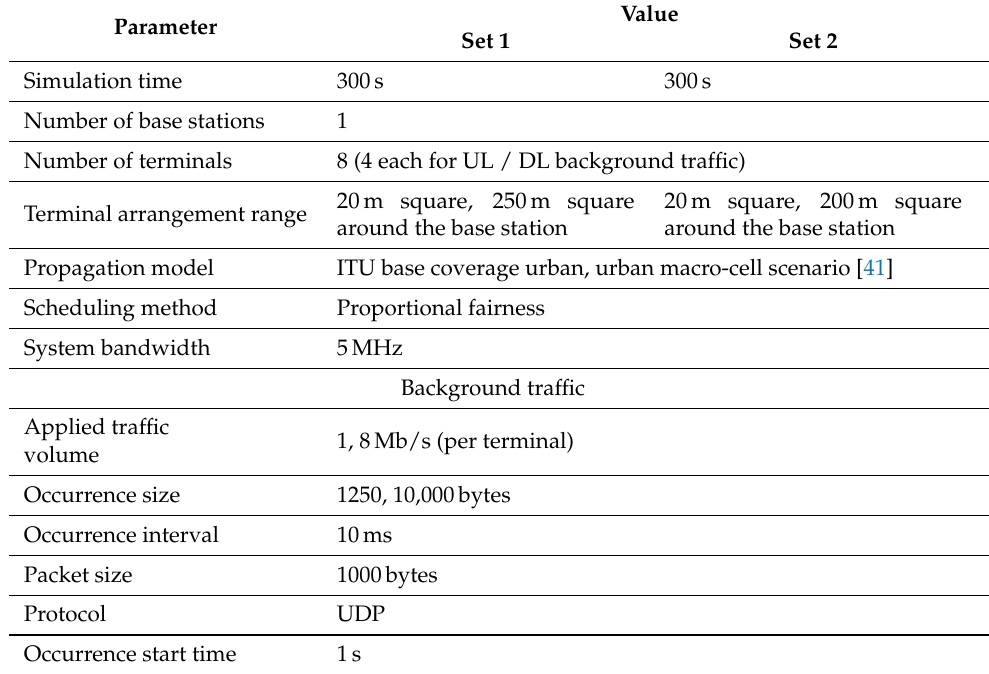
Table 4. Simulation